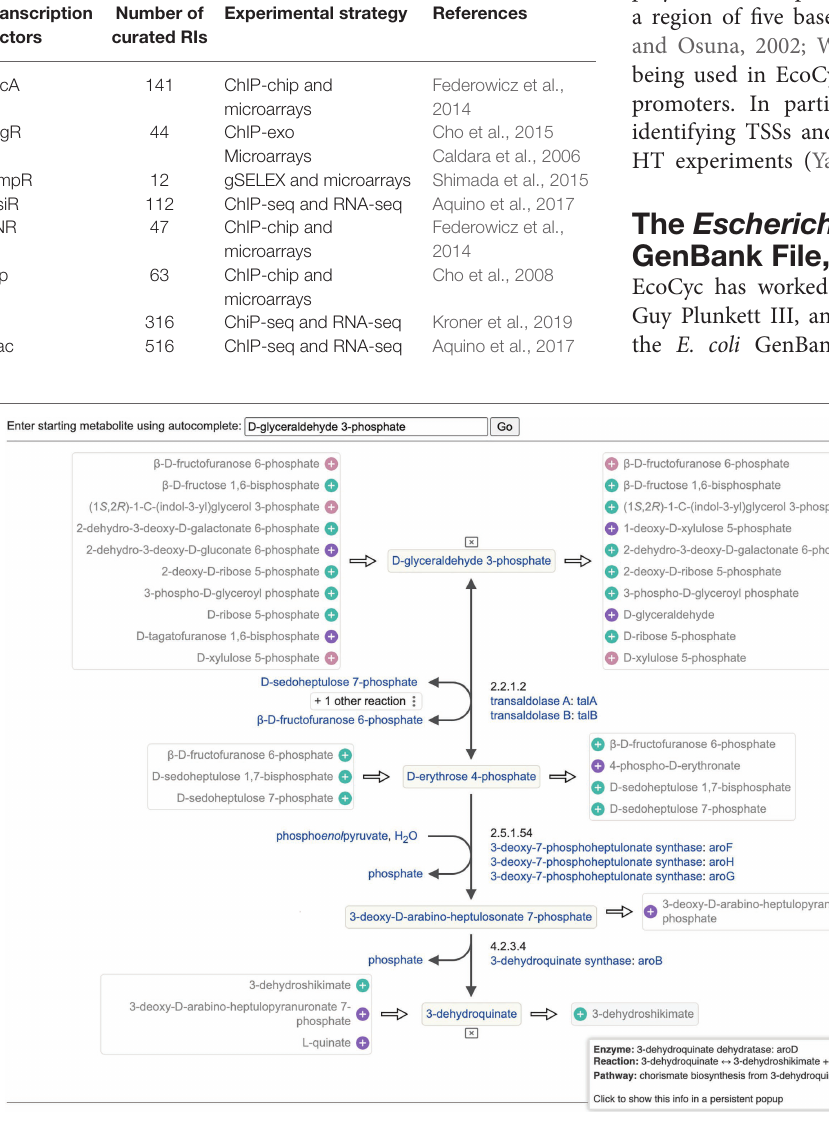
FIGURE 3 | Example display of the Metabolic Network Explorer to explore Escherichia coli metabolism starting from the metabolite D-glyceraldehyde